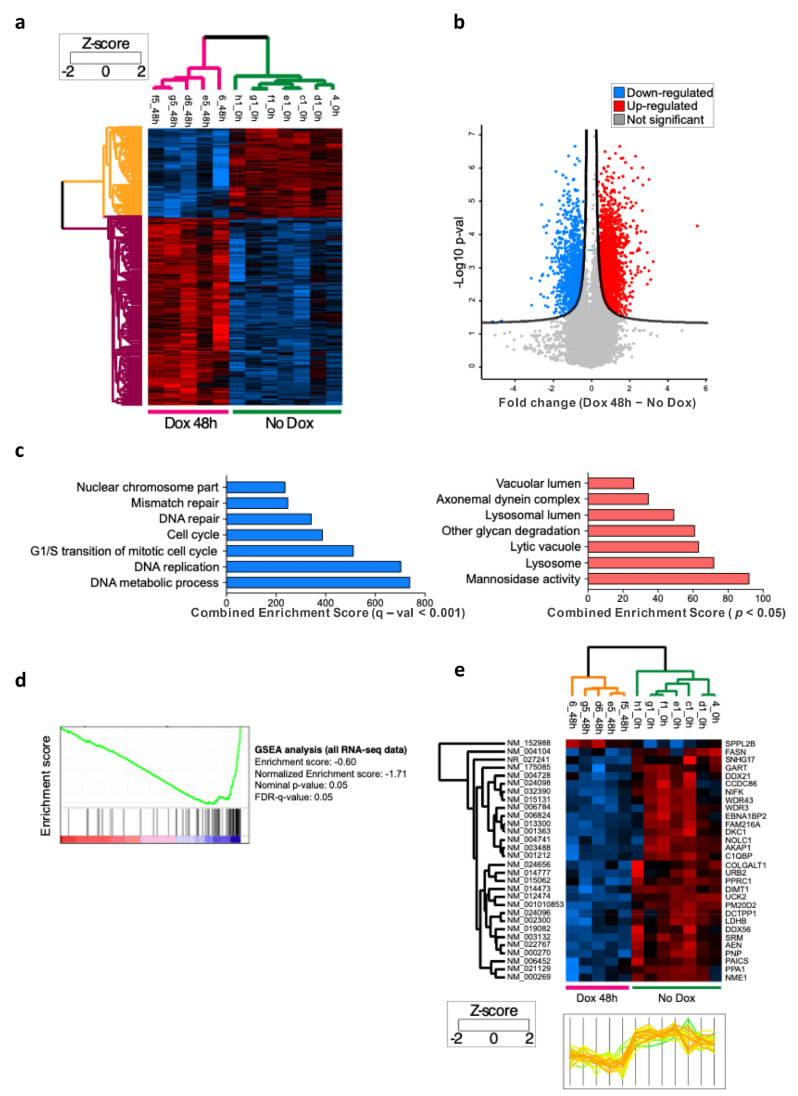
Figure 4. RNA sequencing and pathway analysis. ( a , b ) RNA sequencing analysis shows 2228 genes that are differentially expressed in BT168FO cells upon 48 h Omomyc induction: 1606 up-regulated and 622 down-regulated. ( c ) Functional enrichment analysis of GO terms in down-regulated ( left ) and up-regulated ( right ) genes upon 48 h Omomyc induction. The barplot shows the top enriched GO biological processes, cellular components, and molecular functions. ( d ) GSEA analysis with an enrichment score that confirmed the down-regulation of the Muhar signature (Muhar et al., 2018) [59] of direct MYC targets genes upon Omomyc induction. ( e ) Heatmap with profile plot of a subset of differentially expressed genes that are part of the Muhar signature. The subset includes genes strongly expressed—FPKM at least 10—and differentially expressed, at p -value threshold < 0.05. All of them, except one, were down-regulated upon Omomyc